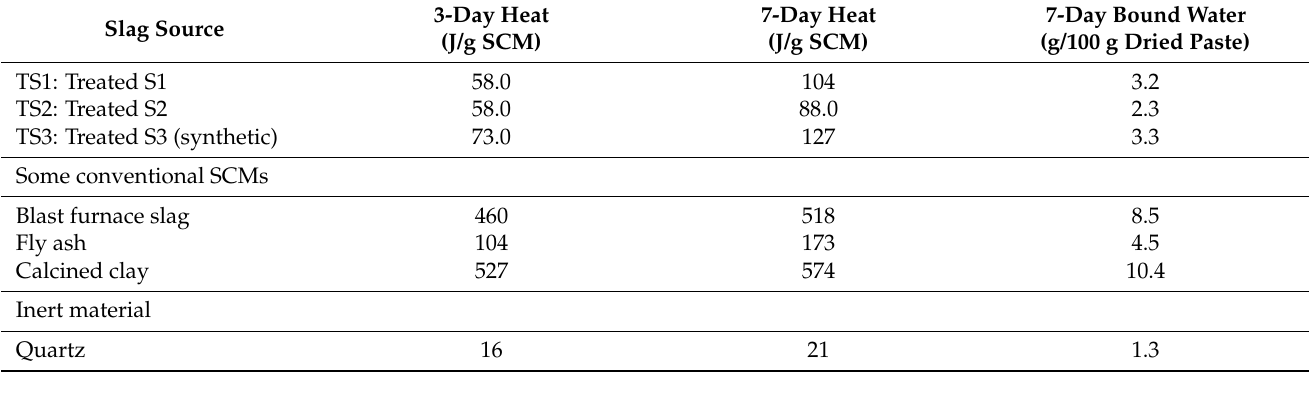
Table 7. R3 test results for the slags, along with some conventional SCMs and inert quartz.